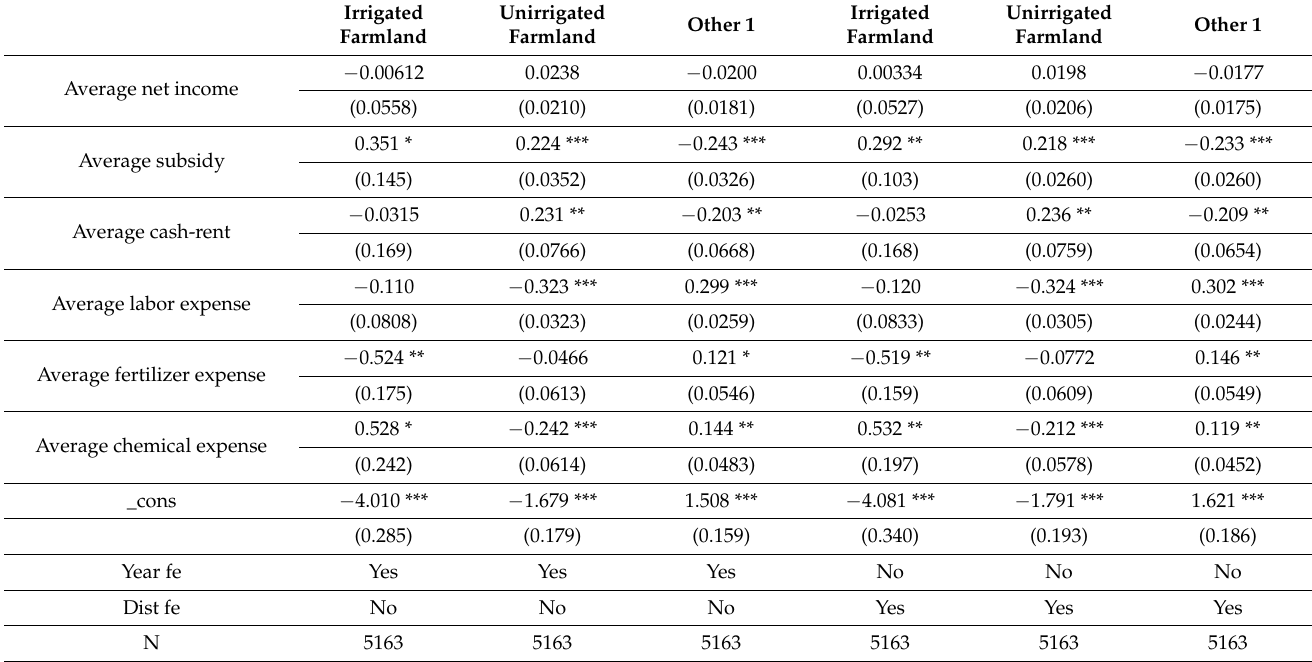
Table 2. Estimated Coefficients on Land-Use of Irrigated Farmland and Unirrigated Farmland in Multinomial-Fractional-Logit Model. Irrigated Farmland